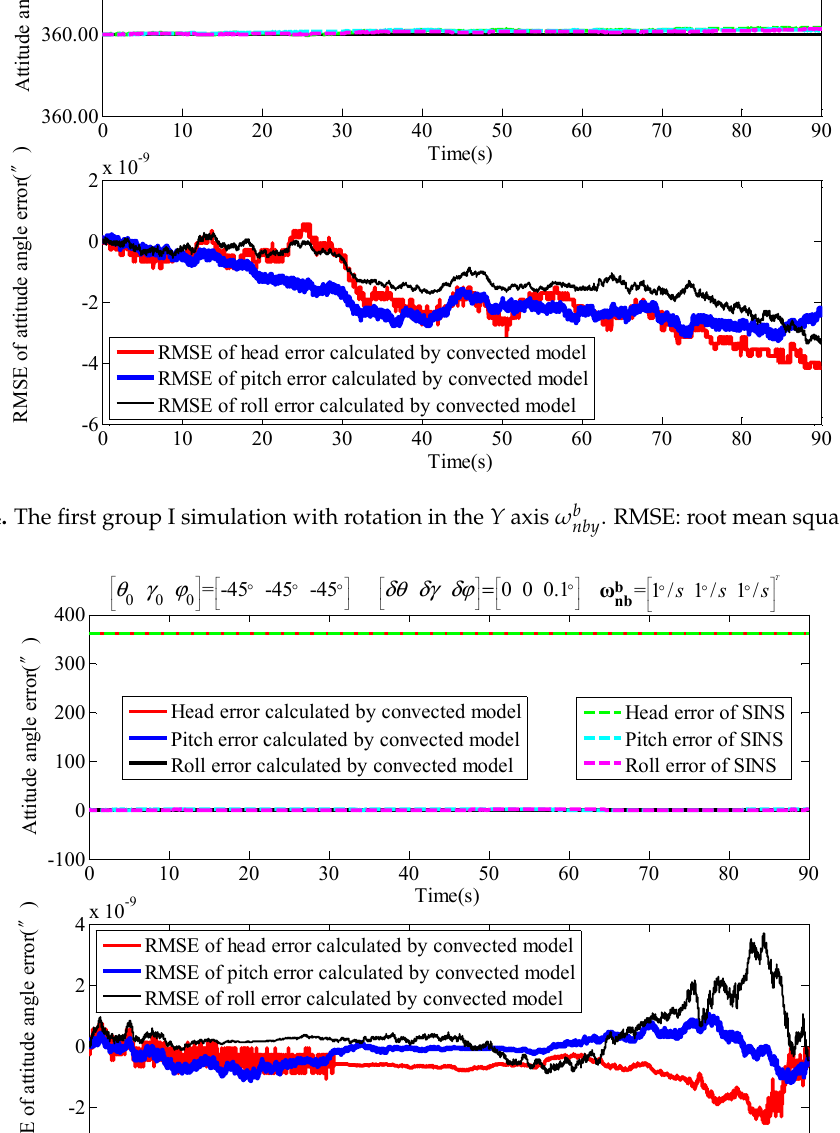
Figure 5. The second group II simulation with the initial head error δϕ 0